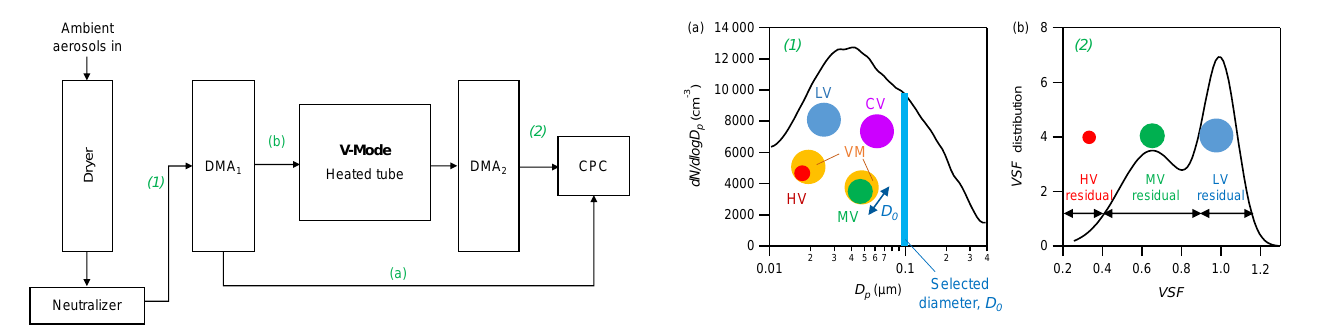
Figure 1. A schematic diagram of the volatility tandem differential mobility analyzer (VTDMA).